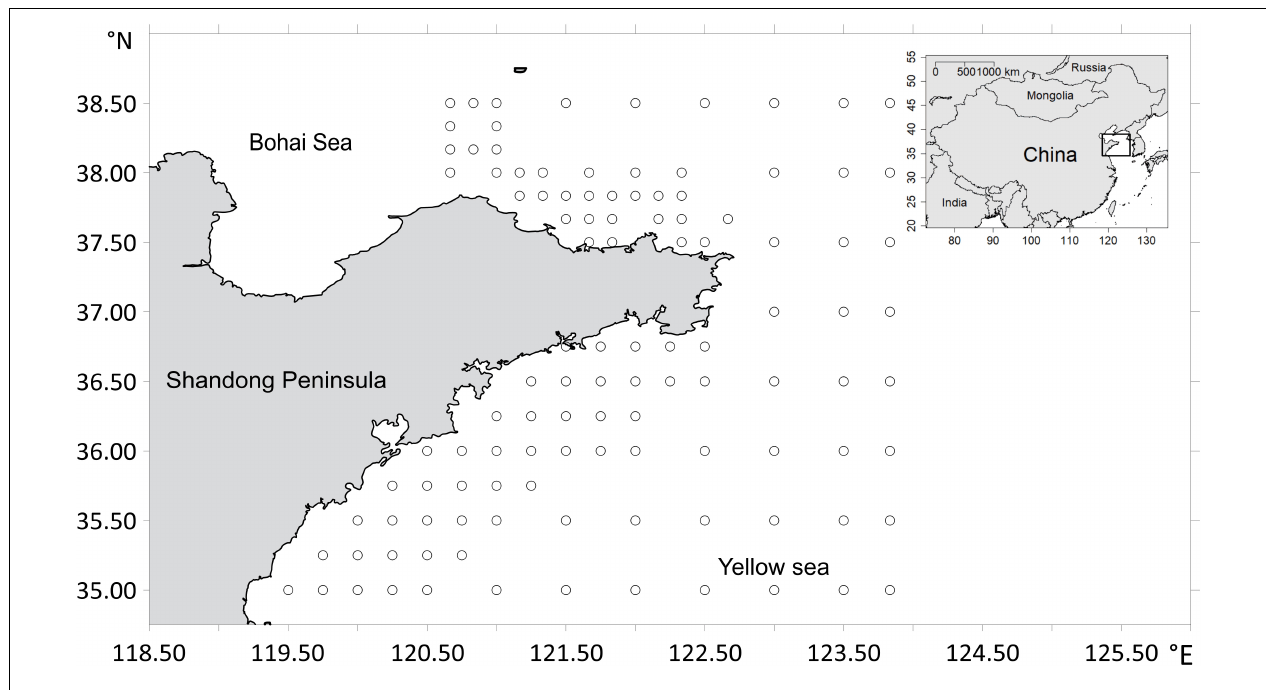
FIGURE 1 | Map of survey stations in the coastal waters of Shandong Peninsula.